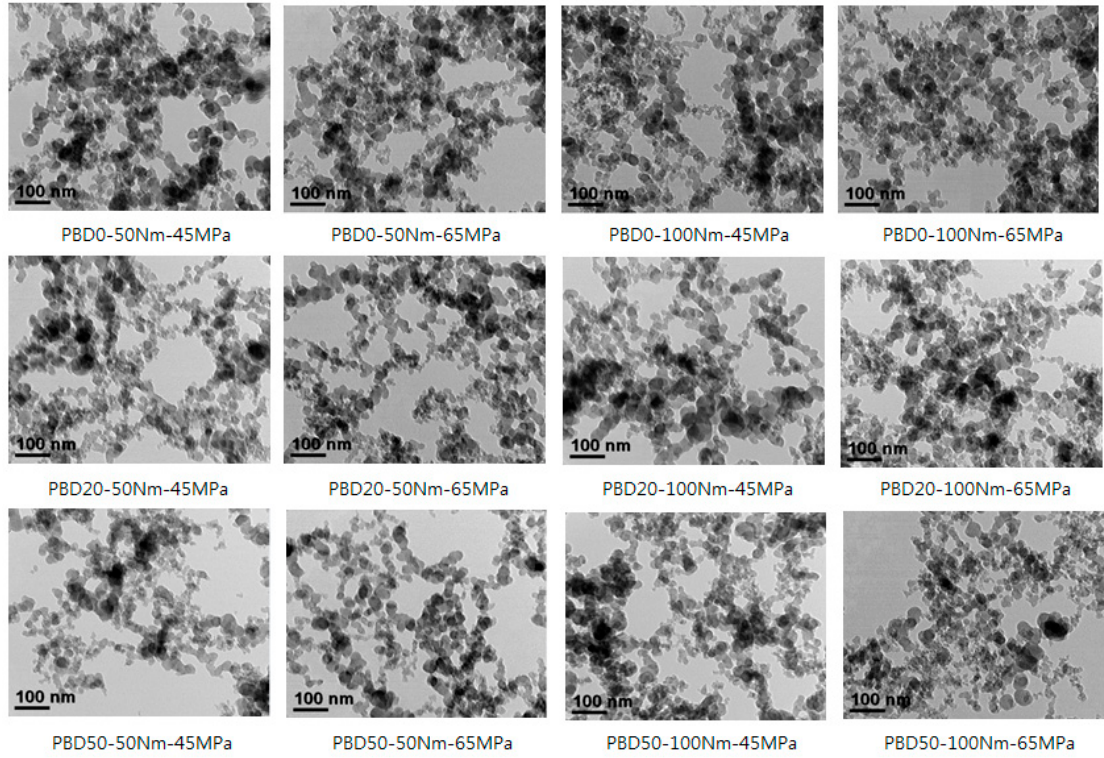
Figure 8. TEM images of the PM emissions for different engine loads and fuel injection pressures changes.